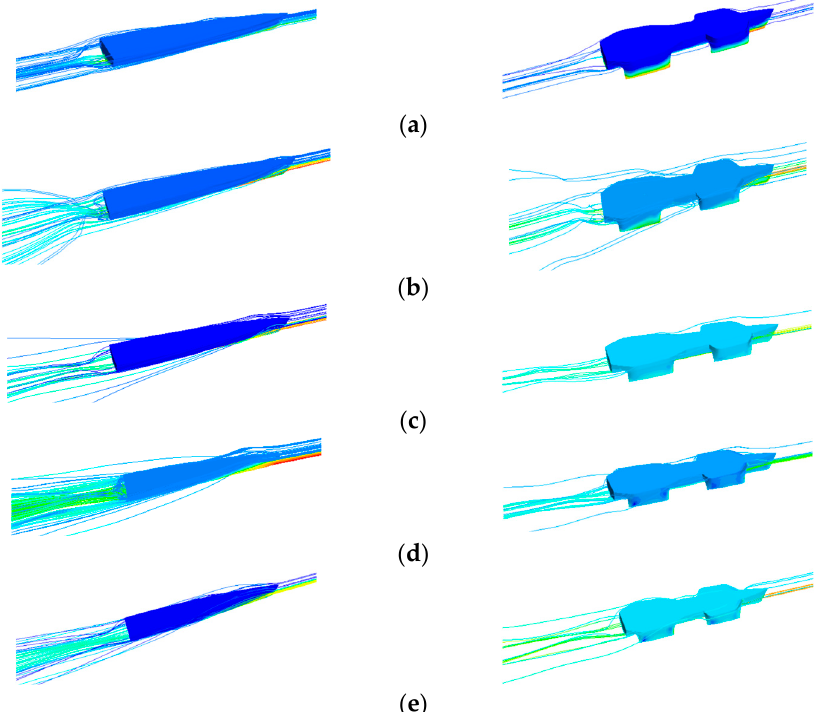
Figure 19. The streamline distribution of the monohull (left) and pentamaran (right) in calm water: ( a ) case 1; ( b ) case 2; ( c ) case 3; ( d ) case 4; ( e ) case 5.